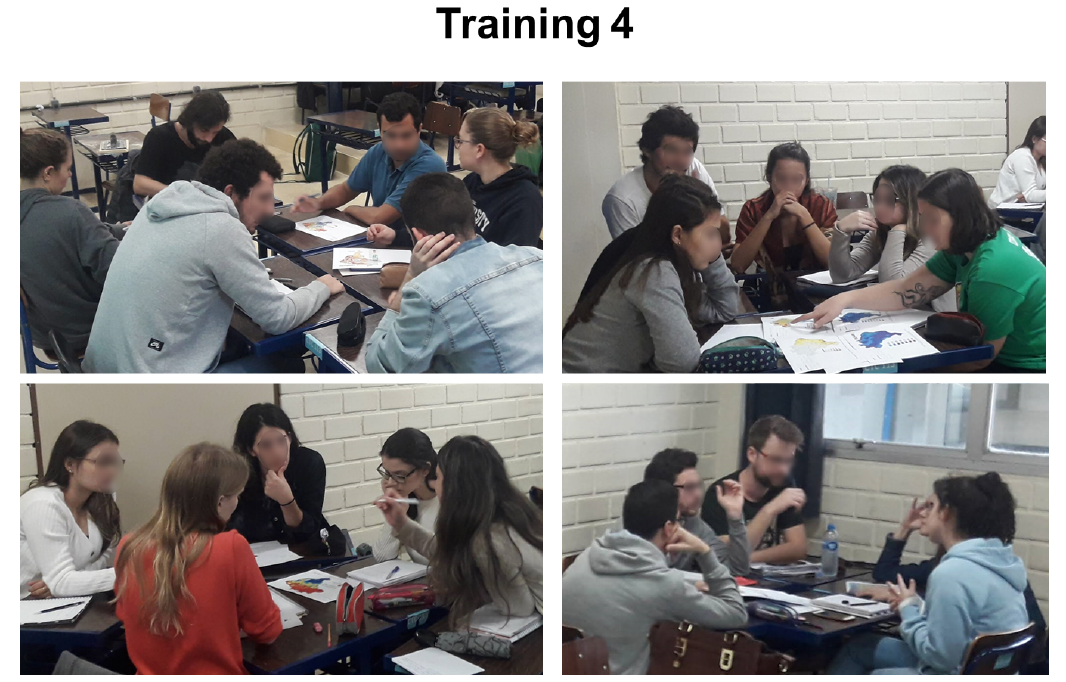
Figure A21. Photos of the groups working on the activities of the fourth